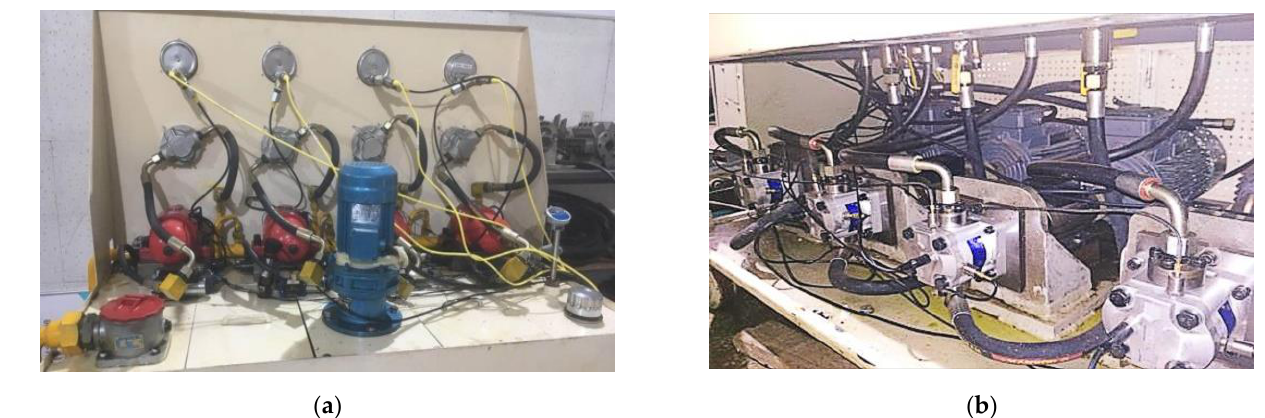
Figure 3. Life-cycle test bed of gear pump: ( a ) Topside of test bed and ( b ) Underside of test bed.